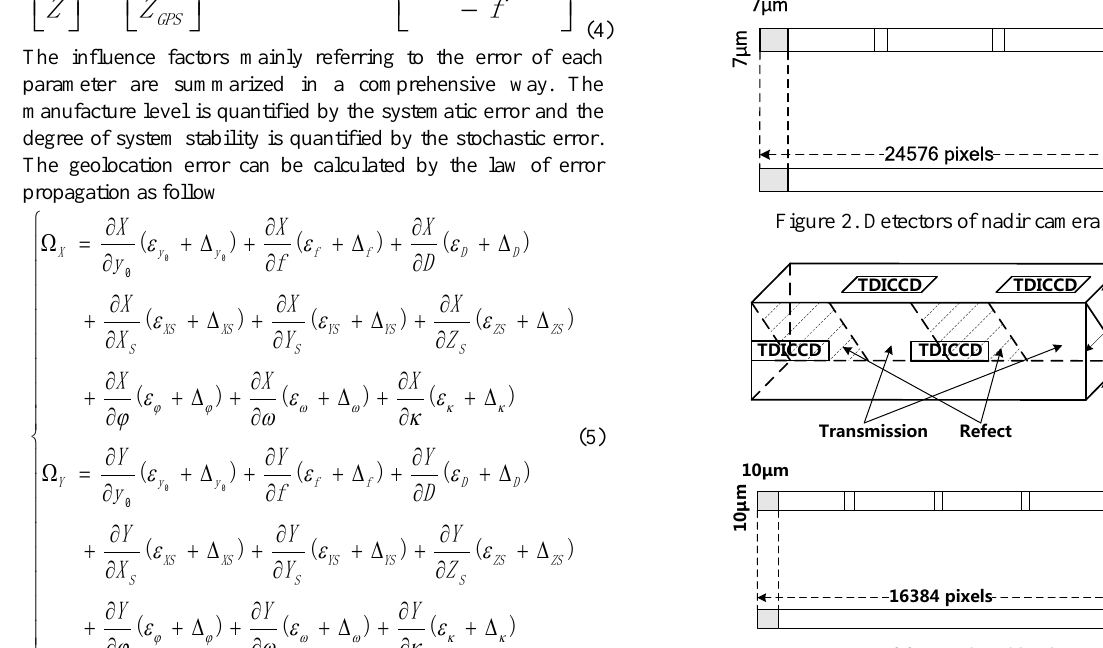
Figure 3. Detectors of forward and backward